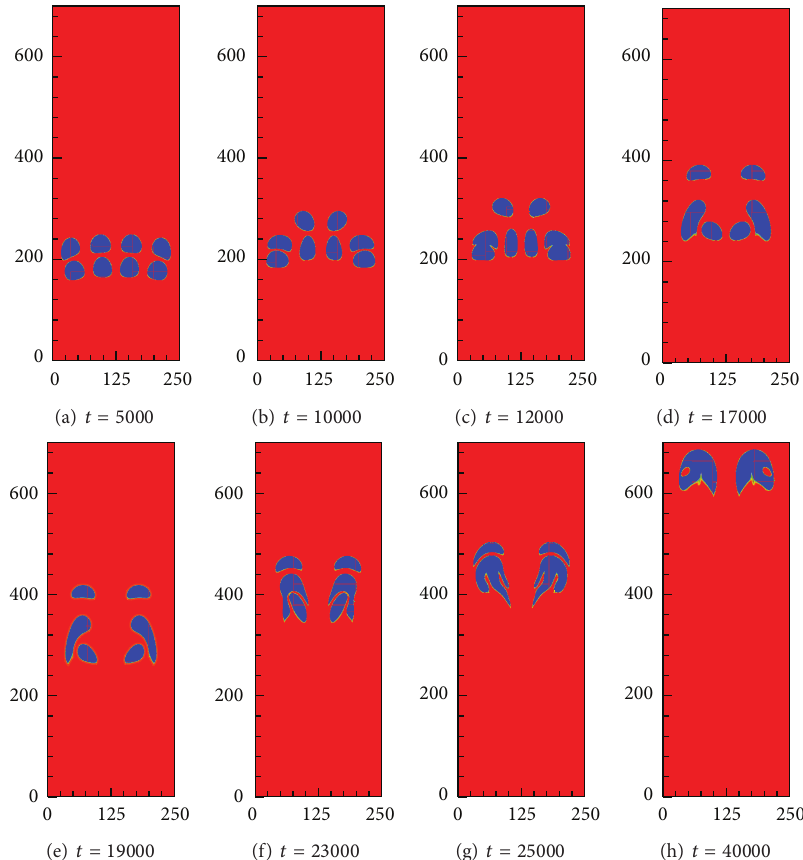
Figure 14: The contours of order parameter of eight bubbles for Eo = 12 .